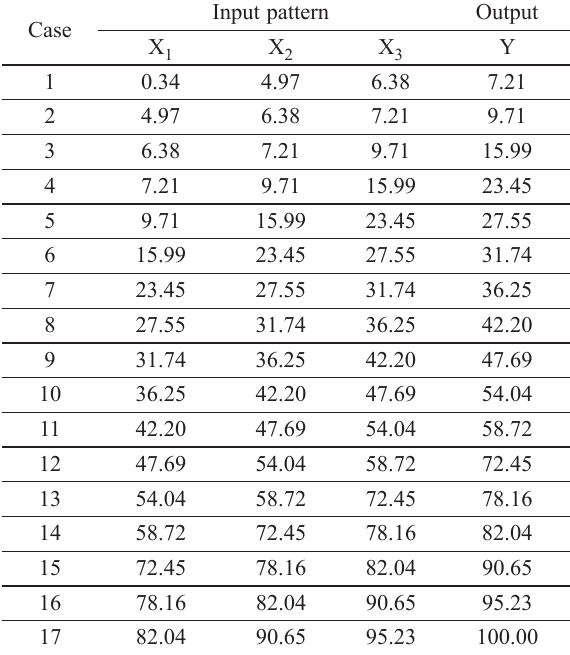
Table 1. Expenditure cash flow for one construction project